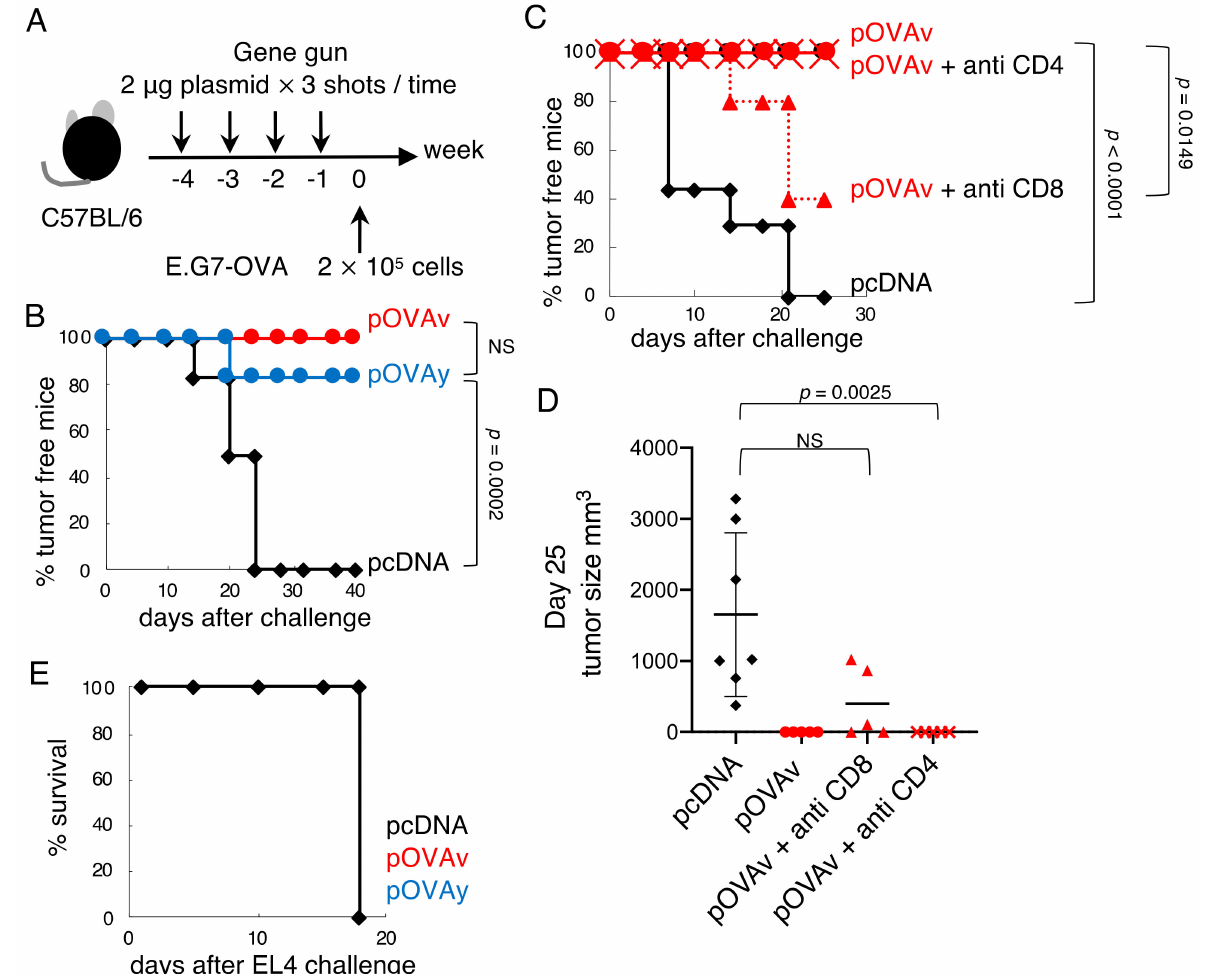
Figure 2. Anti-tumor effect of pOVA with four-time gene gun DNA immunization. ( A ) C57BL/6 mice were immunized four times with the DNA vaccine at one-week intervals and then challenged with E.G7-OVA tumor. ( B ) Percentage of tumor-free mice after immunization with pcDNA (black, n = 12), pOVAv (red, n = 8), pOVAy (blue, n = 12), and E.G7-OVA challenge. ( C , D ) Immunized mice were injected with anti-CD8, anti-CD4, or control antibodies before and after the E.G7- OVA challenge. The percentages of tumor-free mice are shown in ( C ). Tumor size at day 25 is shown in ( D ) (pcDNA [black]: n = 7, pOVAv [red circle]: n = 8, pOVAv + anti CD4 [red x]: n = 5, pOVAv + anti CD8 [red triangle]: n = 5). ( E ) Percentage survival after immunization and challenge with EL-4 tumor without OVA expression ( n = 4/group). Data are the pooled results of one or two independent